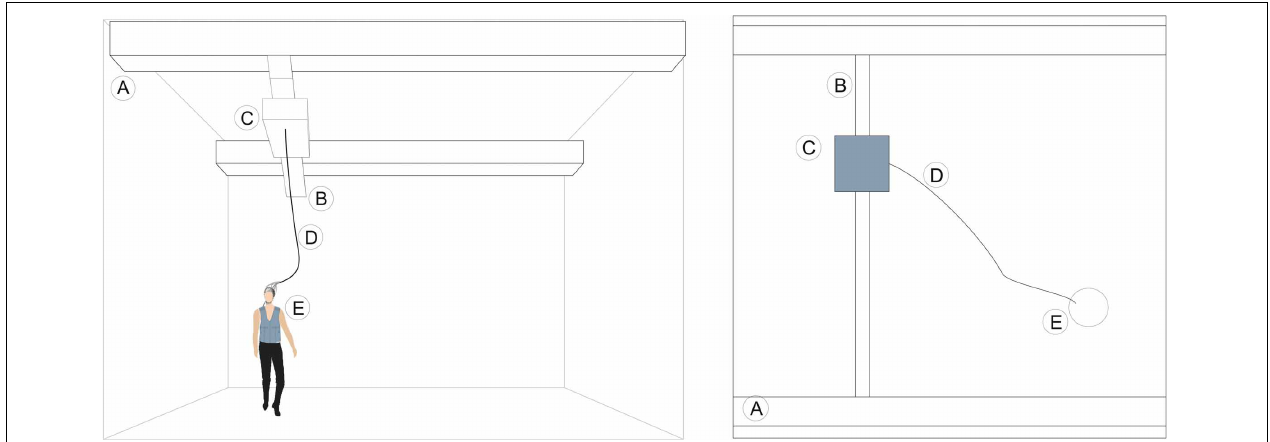
FIGURE 5 | Concept and schematics of the adapted overhead crane. In this figure we can see the relative position of the subject and the overhead crane. A, Wall mounted lateral rails; B, Movable central beam; C, Amplifier